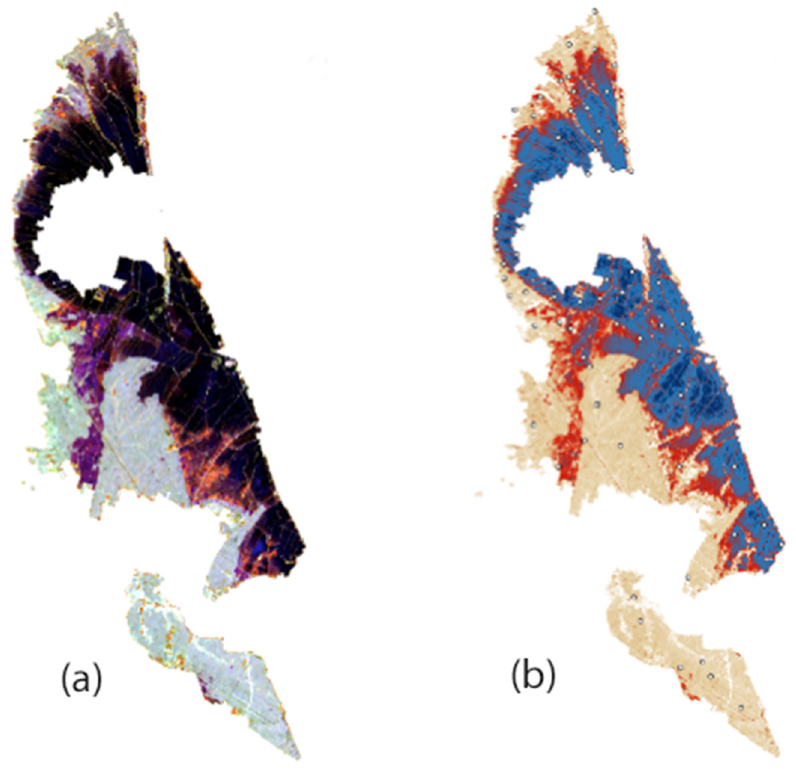
Figure 2. Images of the winter flooding level of paddy fields of the Valencian rice area: ( a ) combination of layers B8A, B11, and B04 from Sentinel-2 multispectral images (January 2019); ( b ) representation in false colour, with sampling points for seedbank estimation.